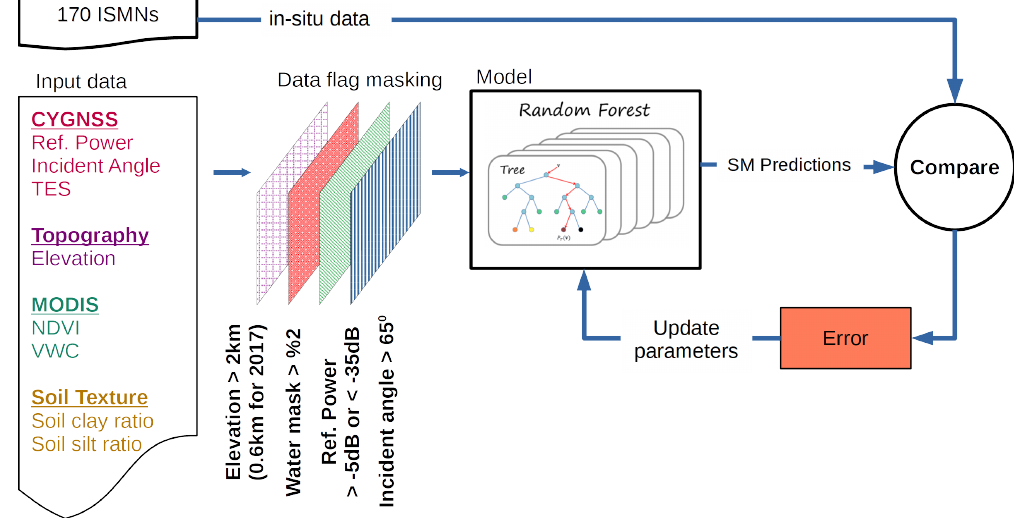
Figure 2. Simplified random forest (RF) model training